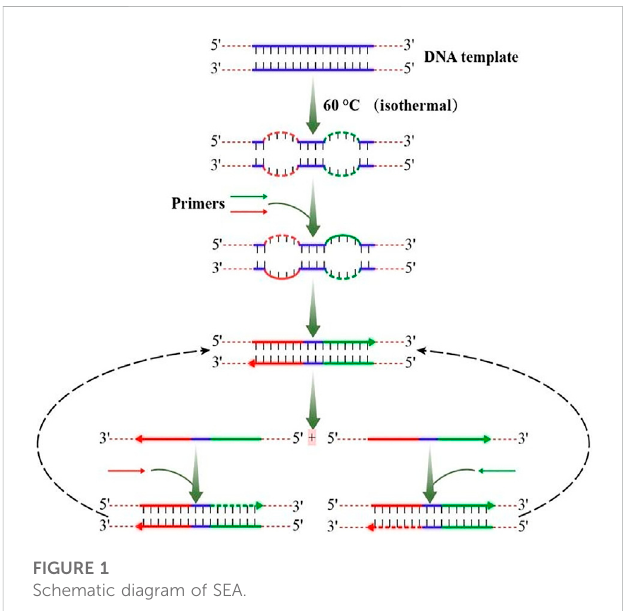
FIGURE 1 Schematic diagram of